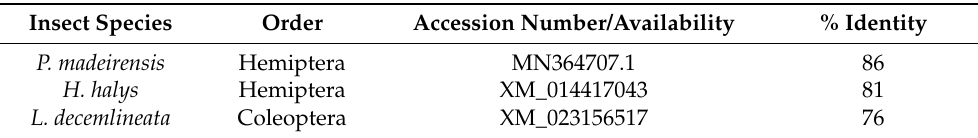
Table 1. Percentage identities of insect v - ATPaseA genes to the v - ATPaseA dsRNA sequence used for Micro-tom